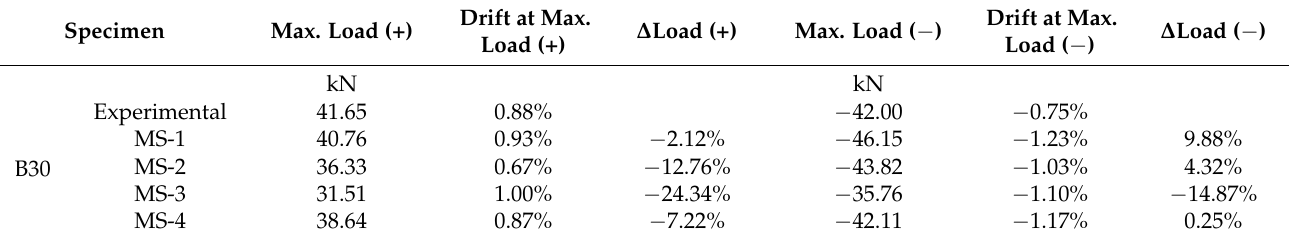
Table 9. Main results of corroded specimens B30, experimental vs. numerical.